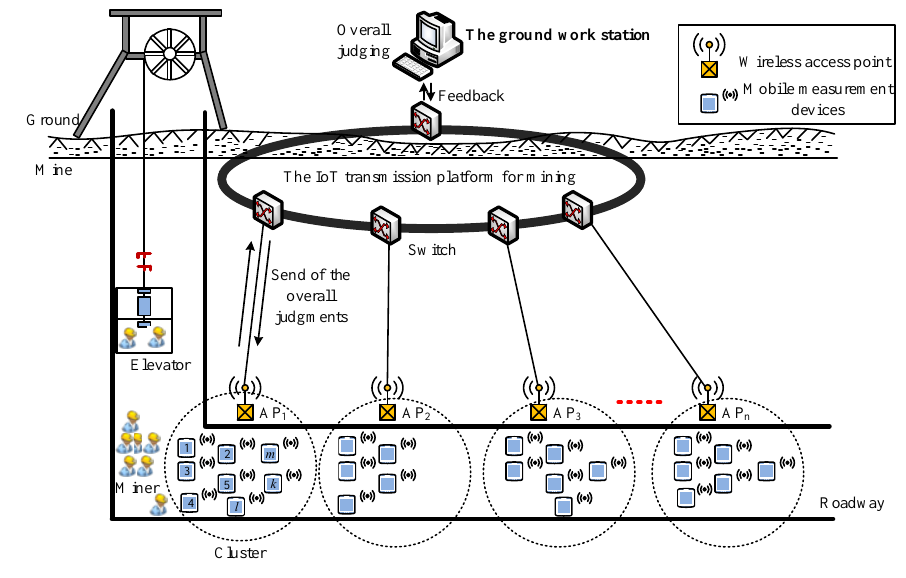
Figure 1. Model of the mine IoT monitoring system.